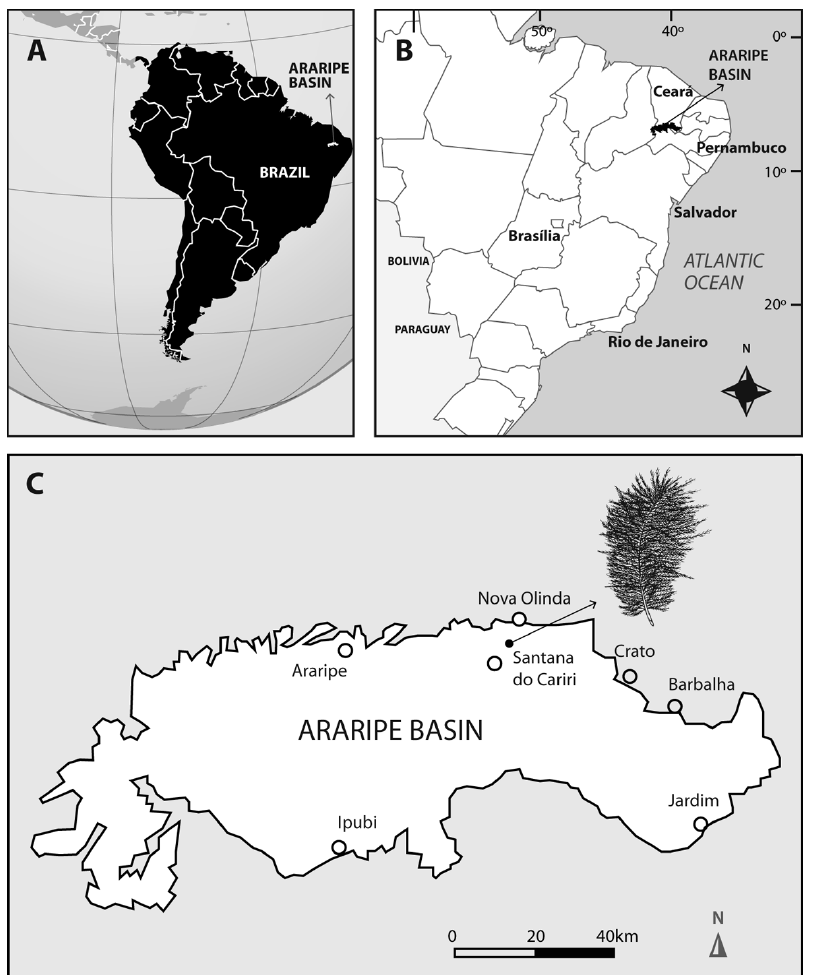
Fig. 1 – A. Location of the Araripe Basin in South America. B. The Araripe Basin bordering the states of Ceará, Piauí and Pernambuco in northeast Brazil. C. Outline map of the Araripe Basin, indicating the site of the mine where the new feathers were found, between the cities of Nova Olinda and Santana do Cariri (Ceará State).